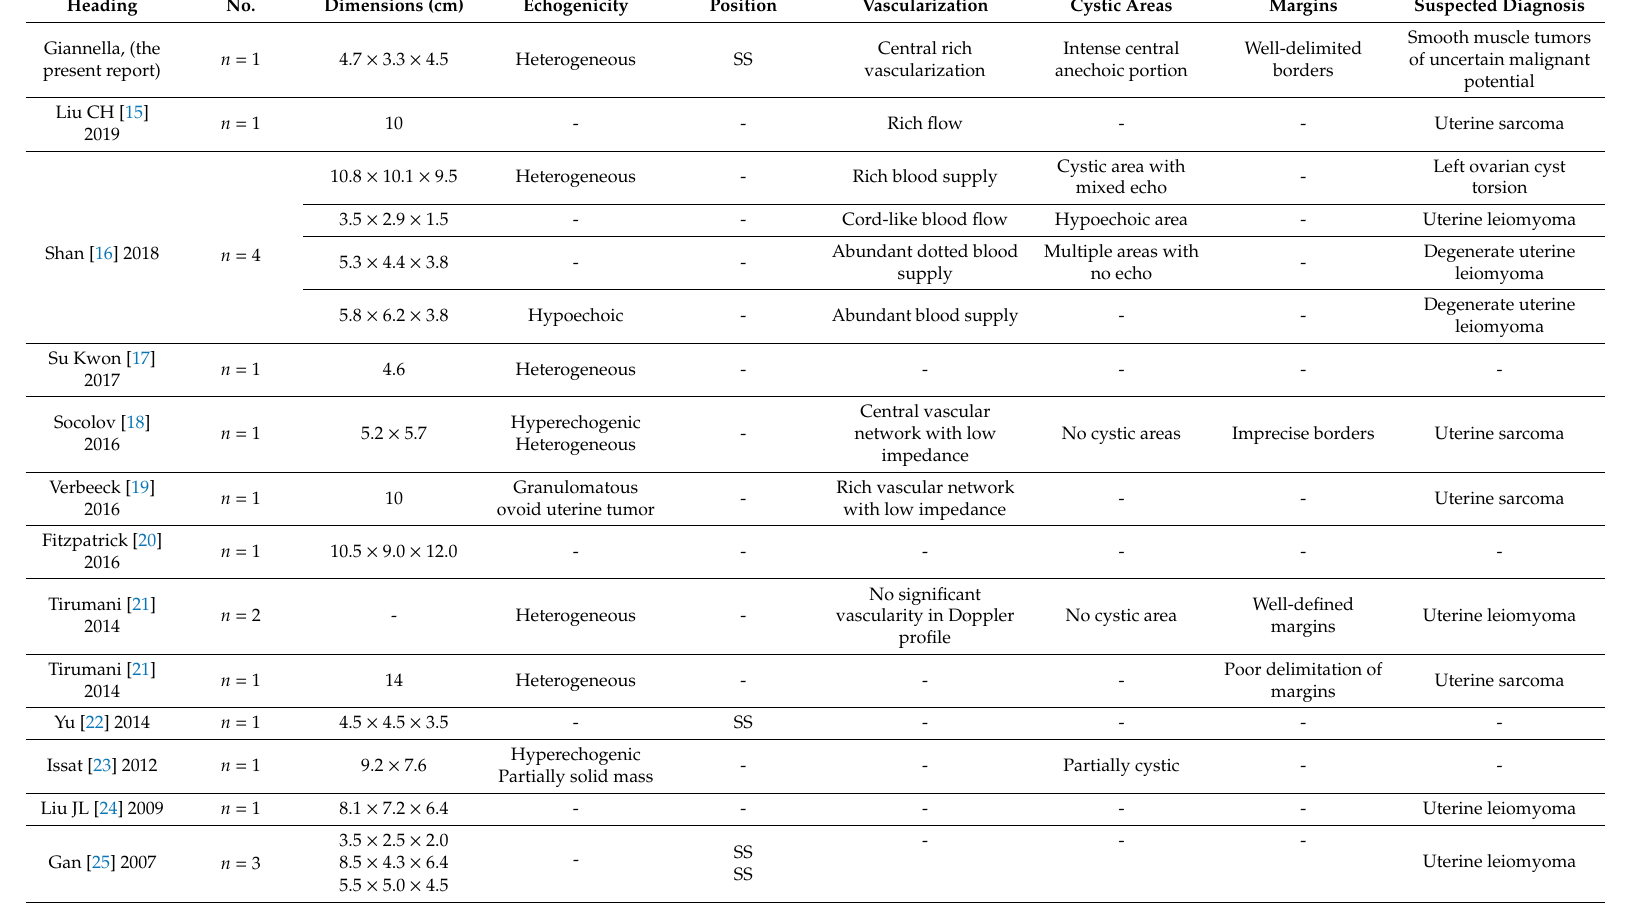
Table 1. Ultrasonographic features of uterine